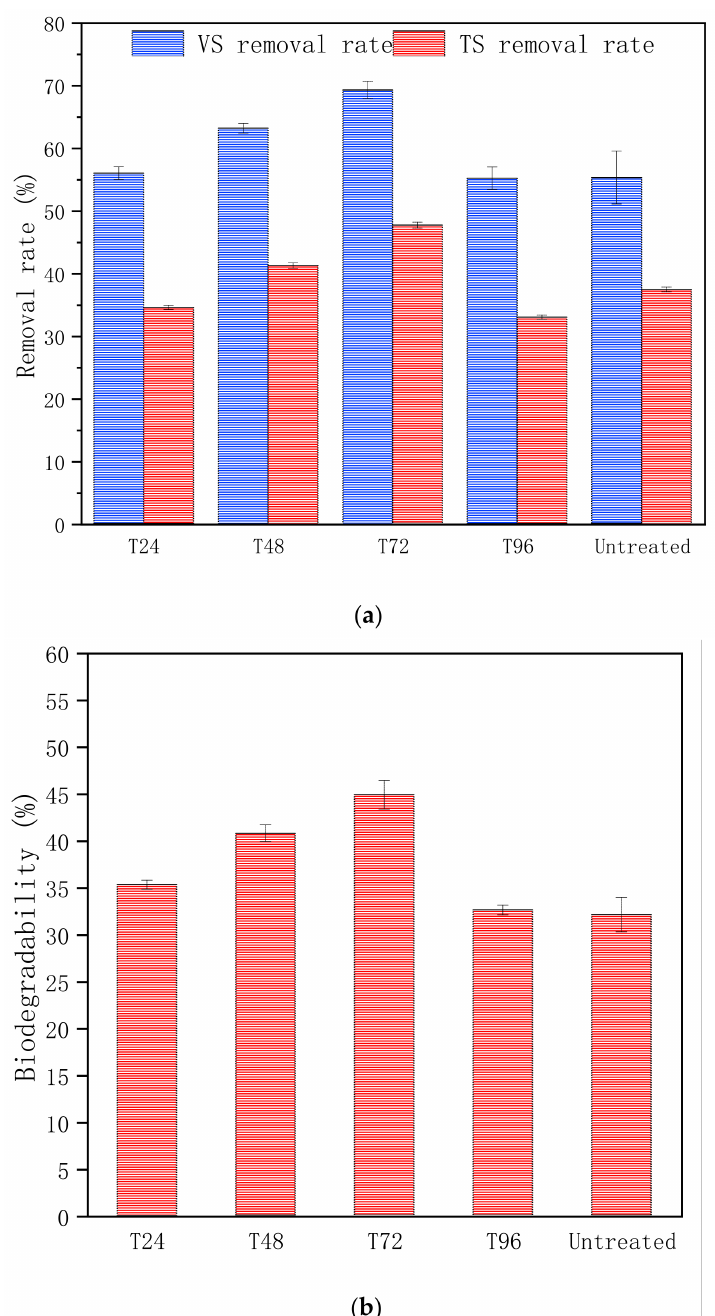
Figure 3. ( a ) TS/VS removal rates for pretreated and untreated corn stover; ( b ) Biodegradability for pretreated and untreated corn